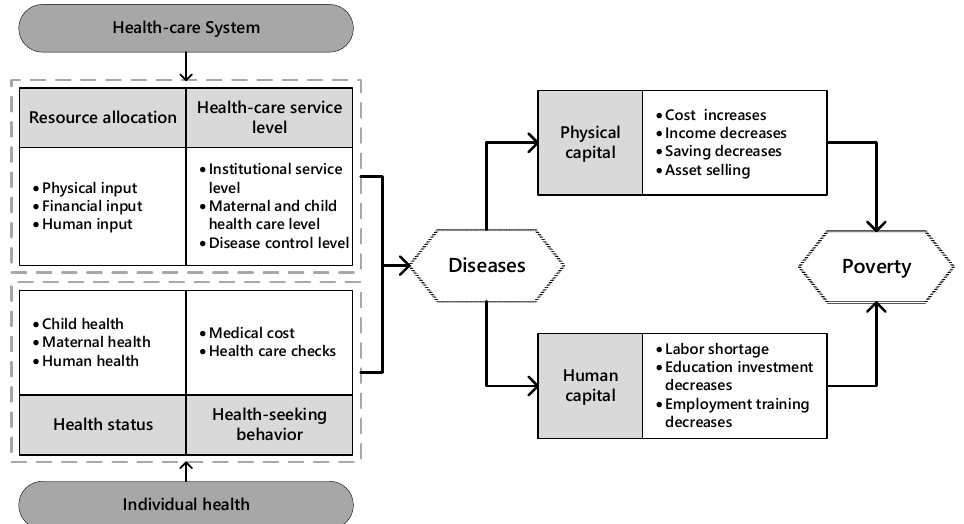
Figure 1. Theoretical framework of the impact of multidimensional health levels on poverty.